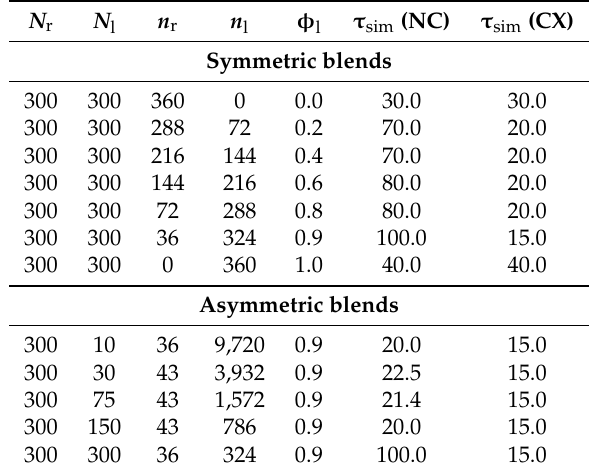
Table 1. Description of the symmetric ( N r = N l ) and asymmetric blends ( N r (cid:54) = N l ) blends simulated in a periodic cubic box with L = 60, at a total density of ρ = 0.5. Simulation times for the non-crossing (NC) and crossing (CX) simulations are in units of 10 6 Monte Carlo